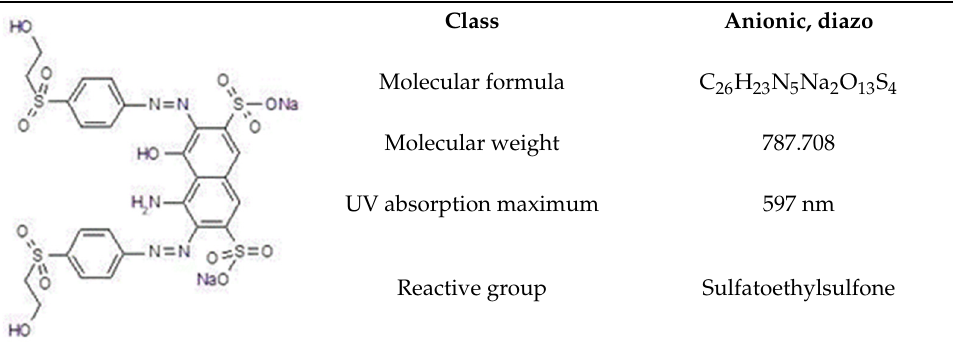
Table 1. Properties of the hydrolyzed Reactive Black 5 (hydRB5).